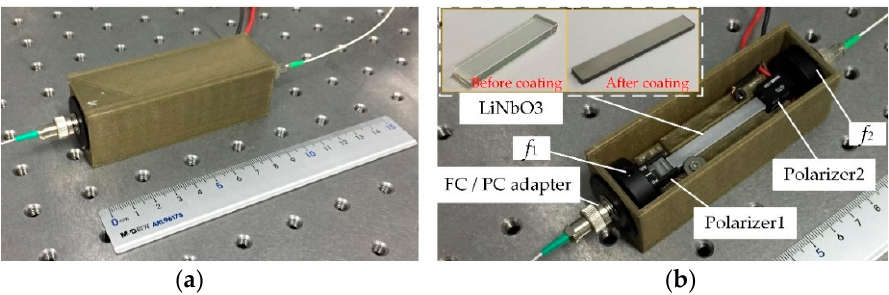
Figure 3. Compressed sensing spectrometry system: ( a ) Appearance; ( b ) Internal structure.